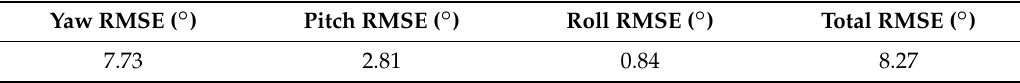
Table 7. Error values of camera orientation